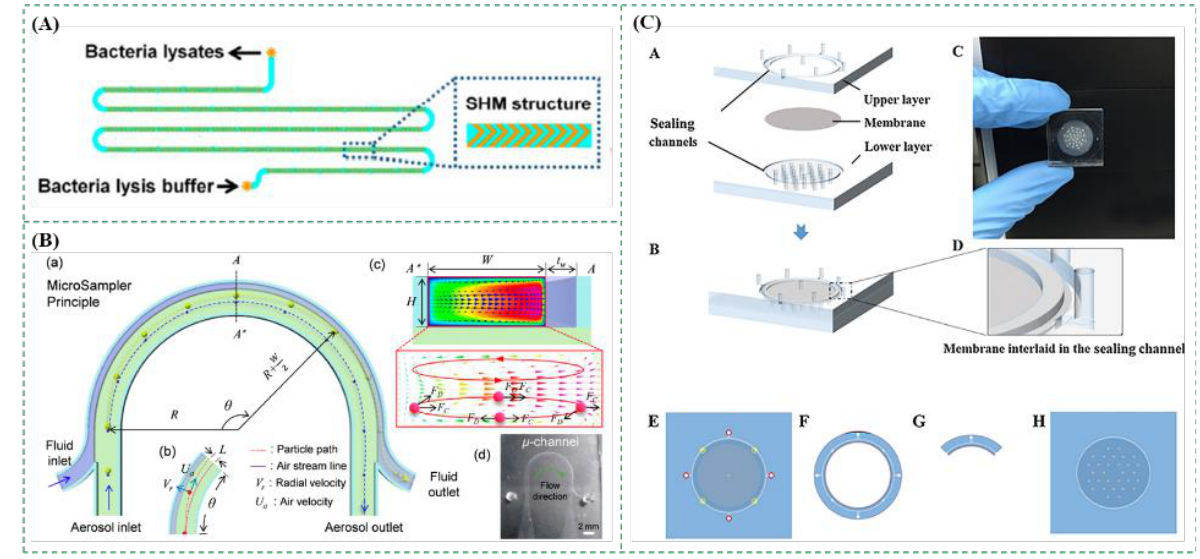
Figure 6. ( A ) The microfluidic chip with staggered herringbone structures for collection of the bioaerosols containing Mycobacterium tuberculosis . Reprinted with permission from ref. [70]. Copyright 2014 American Chemical Society. ( B ) The microfluidic chip with curved microchannel for collection of the bacterial bioaerosols. Reprinted with permission from